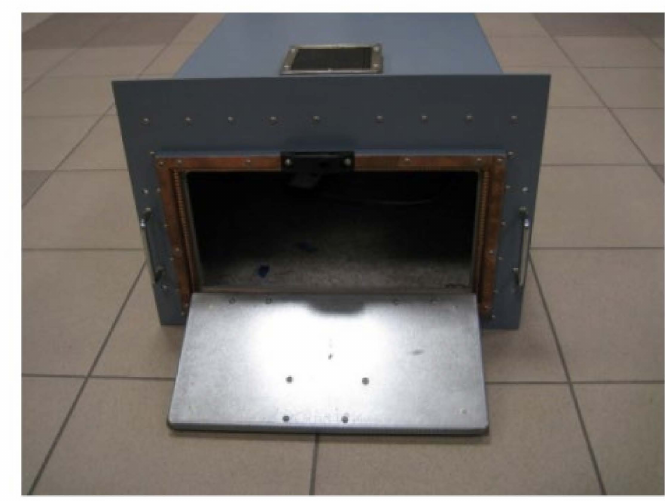
Figure 9. The front panel of the